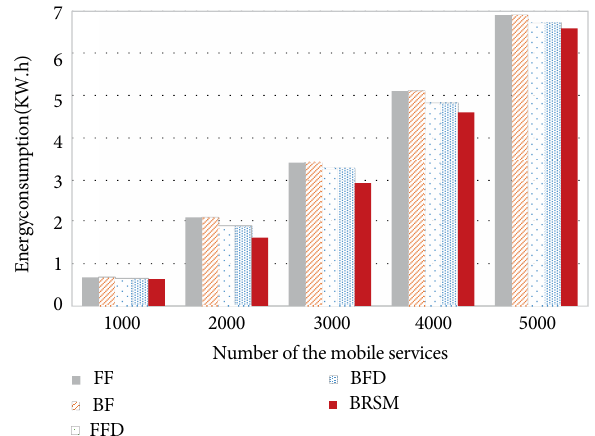
Figure 10: Comparison of energy consumption by FF, BF, FFD, BFD and BRSM.